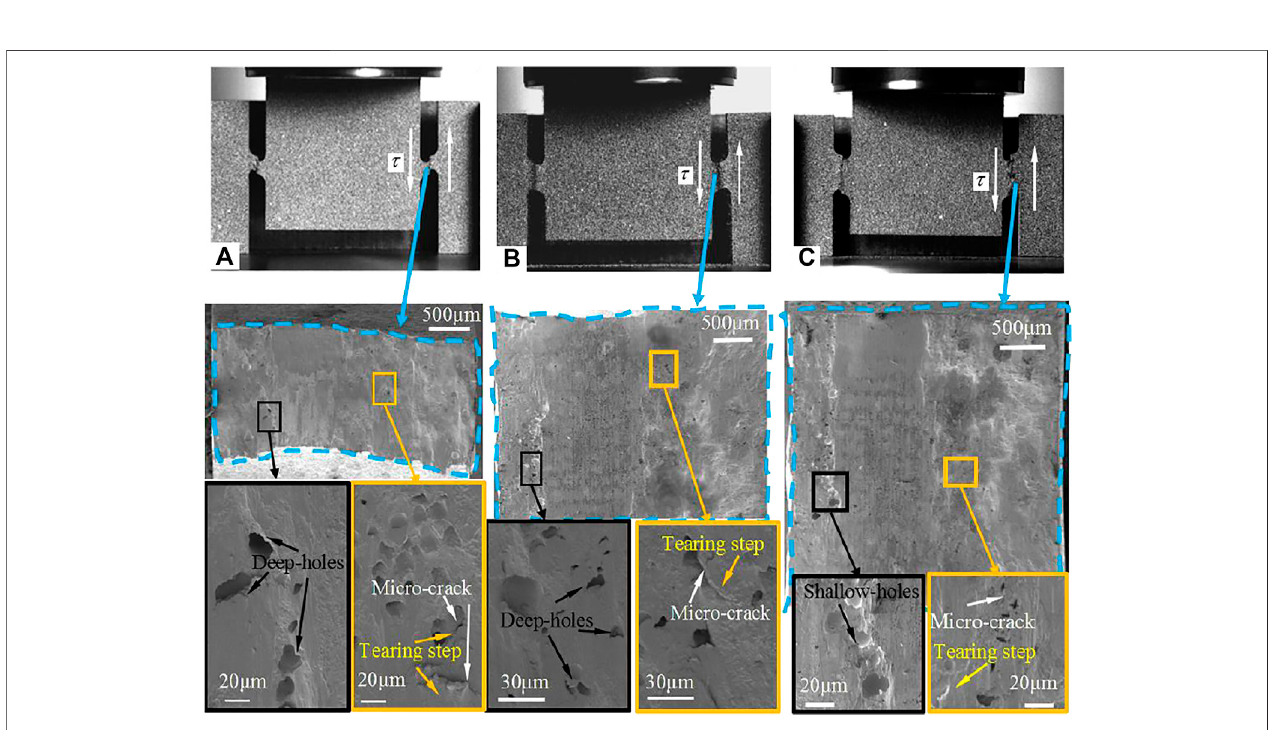
FIGURE 11 | SEM images of the fracture surface of weld specimens with different welding lengths under dynamic test conditions: (A) 2 mm weld specimen (2000 s − 1 ), (B) 4 mm weld specimen (3000 s − 1 ), and (C) 6 mm weld specimen (4000 s − 1 ).